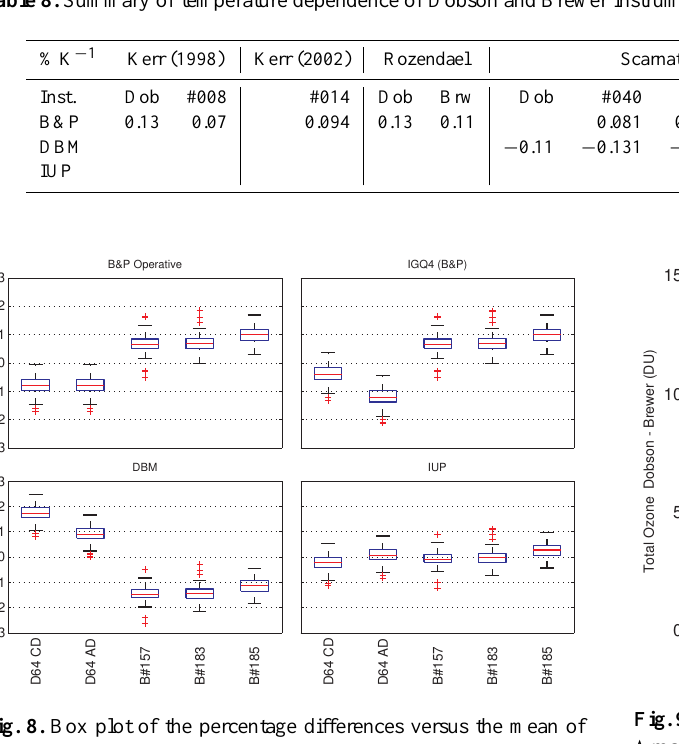
Table 8. Summary of temperature dependence of Dobson and Brewer instruments from previous studies in %K − 1 .